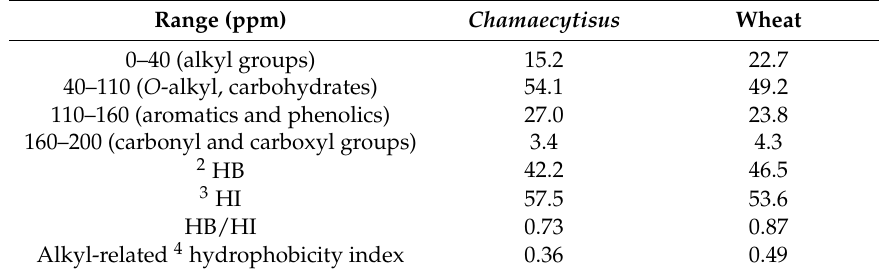
Figure 6. 13 C- 1 H 2D-HSQC NMR spectra of alkyl-oxidized ( δ C/ δ H 50–90/2.5–6.0 ppm) and aromatic ( δ C/ δ H 90–106/6.0–8.0 ppm) regions of lignins isolated from Chamaecytisus proliferus ( A , B ) and wheat ( C , D ), respectively. Spectra for lignins isolated from Leucaena and barley are shown in Figure S2 (Supplementary Materials), due to their close similarities with the spectrum of Chamaecytisus lignin. Labels refer to identified lignin sub-units (shown in Figure 7), whose signal assignment is reported in Table 5. Table 4. Carbon distribution (%) in different chemical shift regions (ppm) in 13 C-CPMAS-NMR spectra of lignins from 1 Chamaecytisus and wheat.